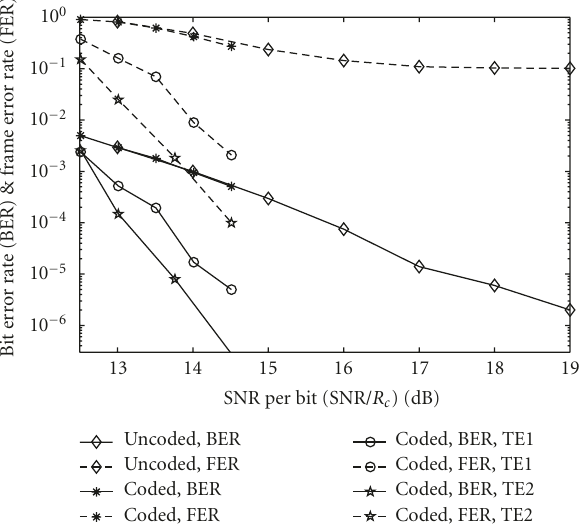
Figure 11: Performance improvement by employing turbo equal- ization, convolutional coded